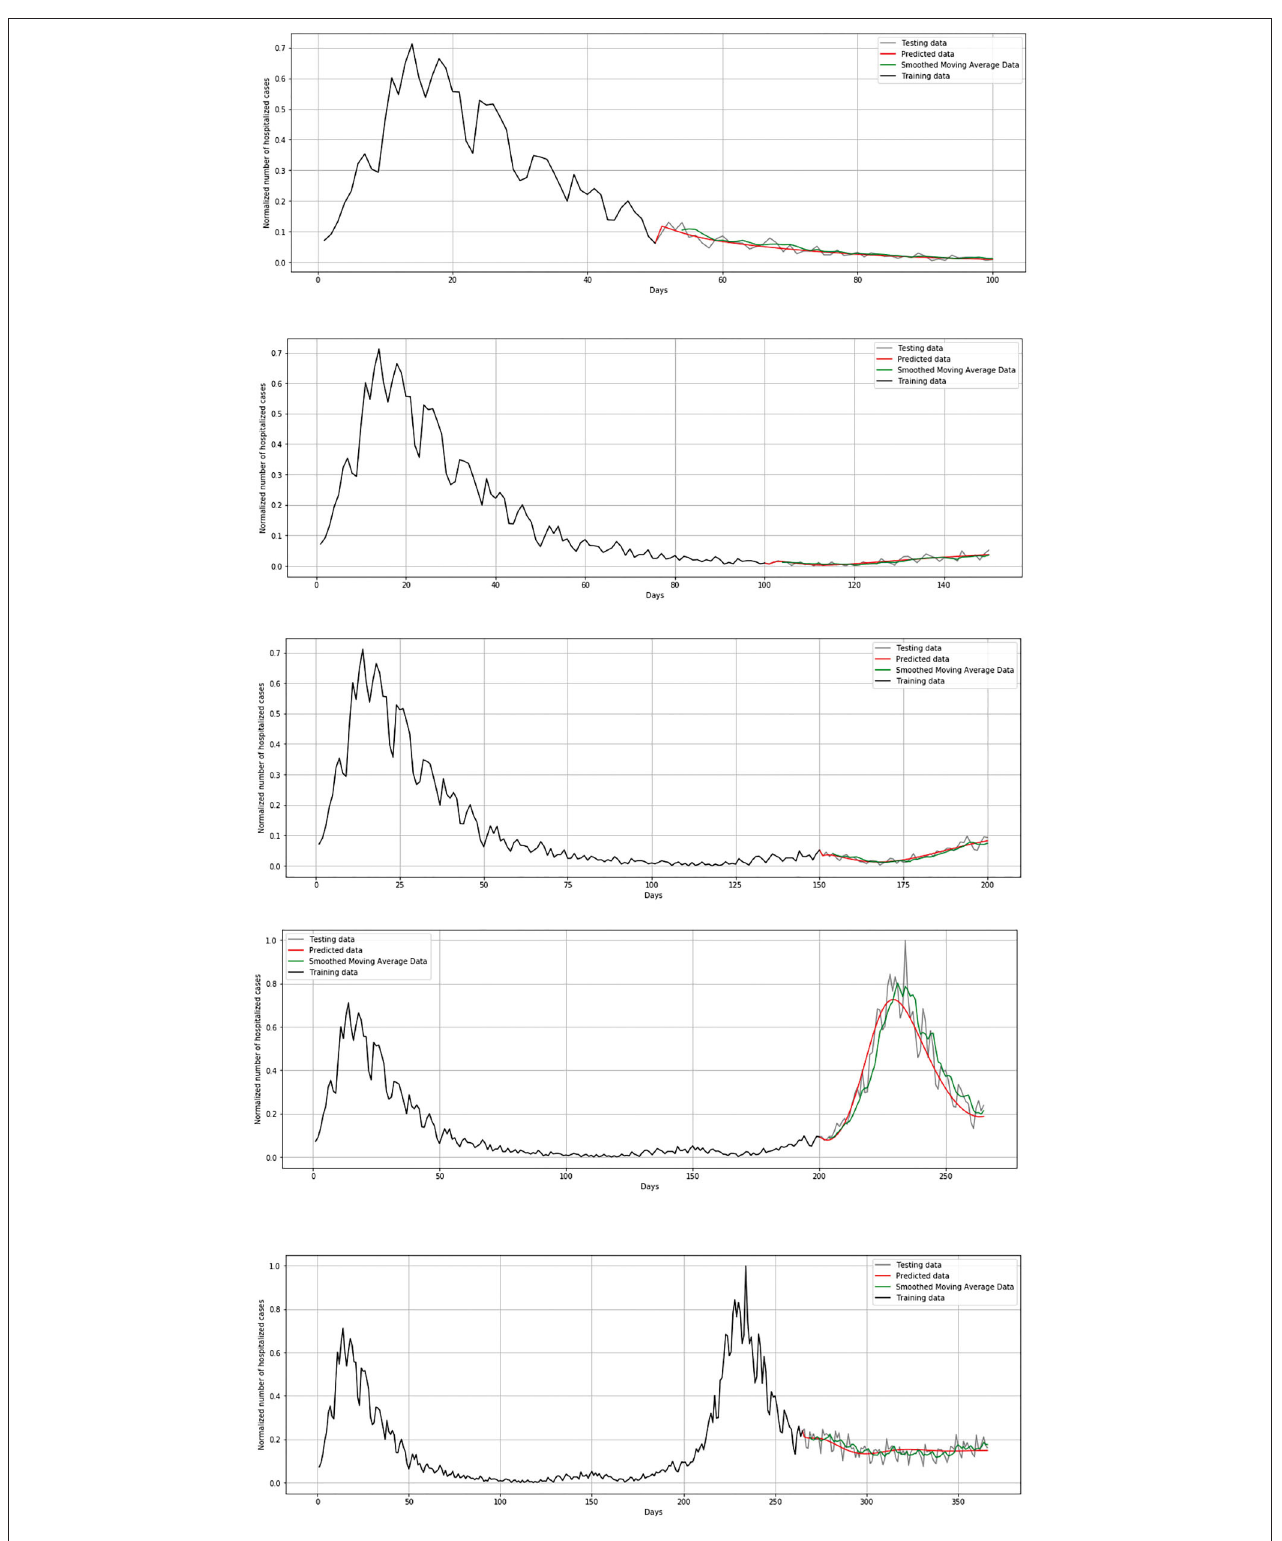
FIGURE 10 | Cross-validation process for hospitalized cases in